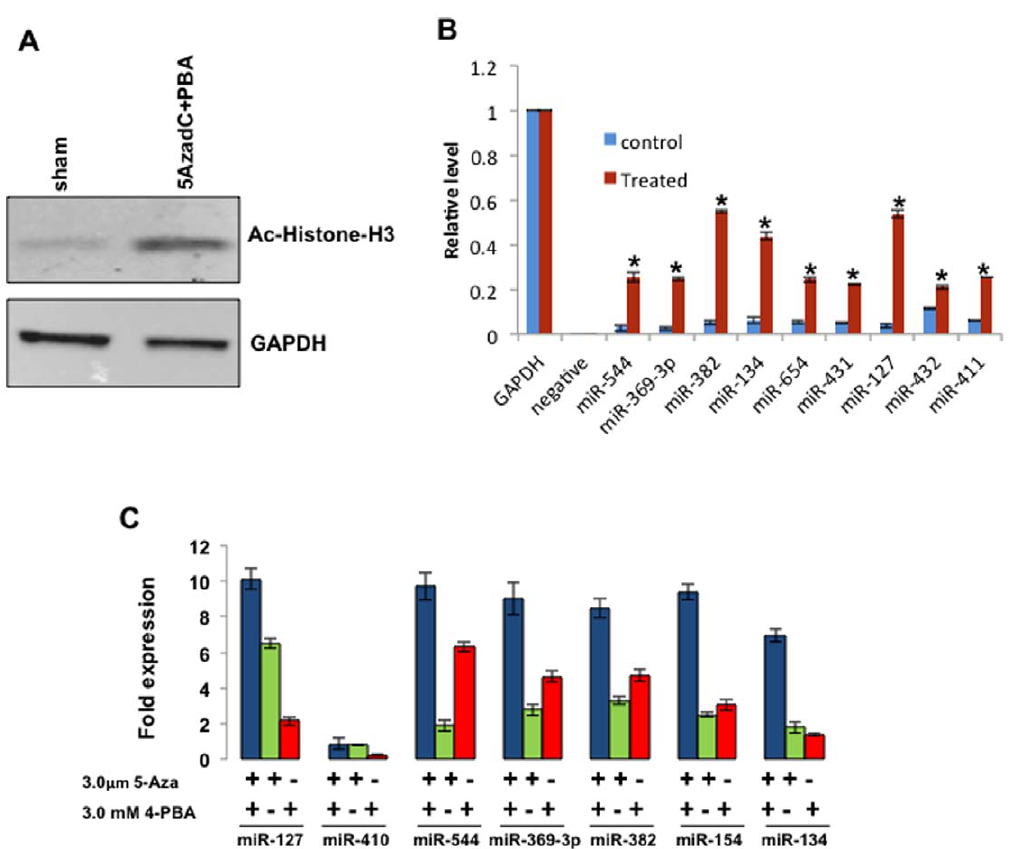
Figure 2. 5-AzadC and 4-PBA activates 14q32 miRNAs expression and destabilize cMYC in Saos2 cells. A ) 5-AzadC and 4-PBA treated Saos2 cells were subjected to western blot analysis with Anti-acetylated histone-H3 antibody; and GAPDH is shown as control. Note an increase in the level of acetylated Histone-H3 in the treated cells. B ) 5-AzadC and 4-PBA significantly increased the acetylation of histone-H3 of representative 14q32 miRNA upstream regions ( 2 200 bp); *p values , 0.005. C ) Quantitative RT-PCR analysis of 14q32 miRNAs following the treatments with 3 m M 5- AzadC and 3 mM 4-PBA. Saos2 cells were treated with 3.0 m M 5-AzadC and 3.0 mM 4-PBA for 6 days, unless otherwise mentioned.